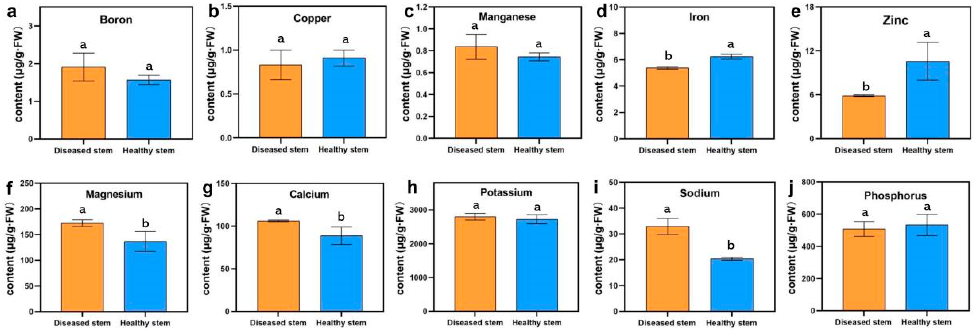
Figure 5. Mineral contents in flat and healthy cucumber stems: ( a ) boron; ( b ) copper; ( c ) manganese; ( d ) iron; ( e ) zinc; ( f ) magnesium; ( g ) calcium; ( h ) potassium; ( i ) sodium; and ( j ) phosphorus. Different letters represent significant differences between flat and healthy stems using Duncan’s test ( p <